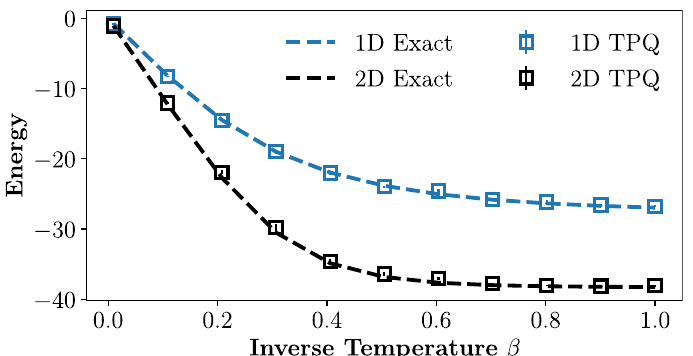
Figure 3. Thermal energy, as a function of inverse temperature β of a 1D Heisenberg model on a 12-qubit lattice (blue) and a 2D Heisenberg model on a 4 3 lattice (black). Shown are results averaged over 10 TPQ state × realizations. The true ensemble thermal energies (dashed) are plotted for